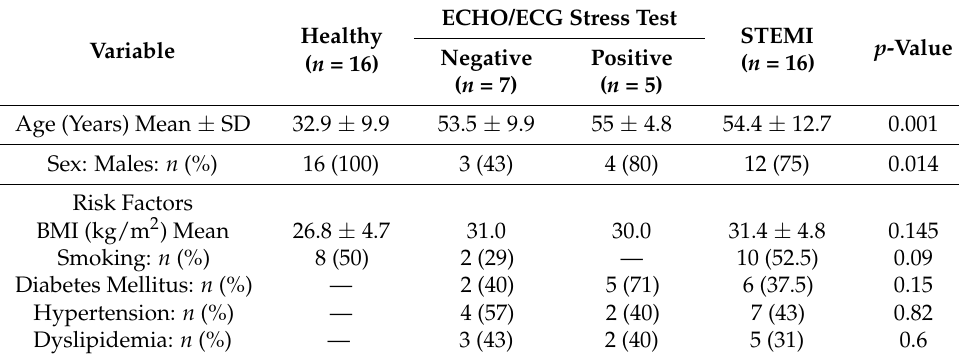
Table 1. Baseline Clinical Characteristics of Different Patient